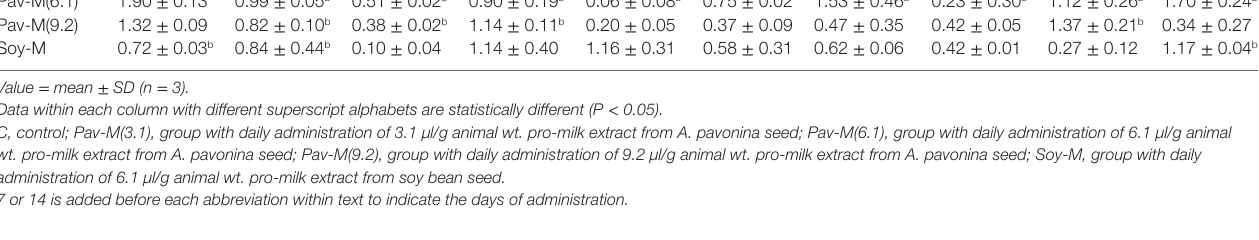
TaBle 6 | Acetylcholinesterase activities in organs of rats administered with milk extract from Adenanthera pavonina and soy bean. Parameters Brain